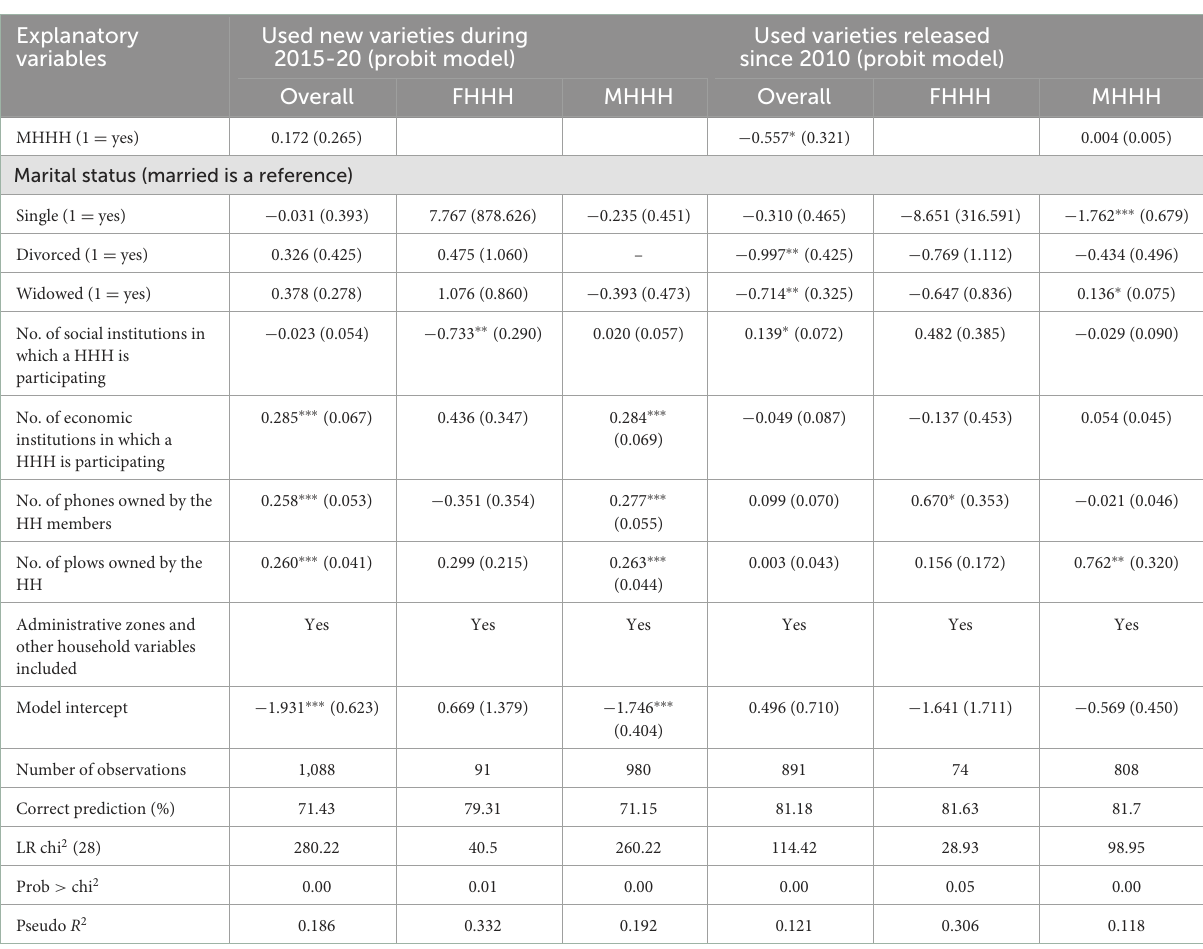
TABLE 7 Determinants of adoption of new wheat varieties. Explanatory variables